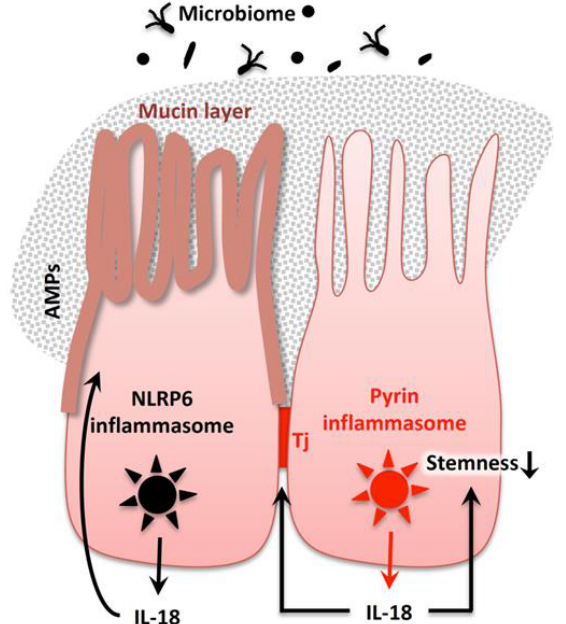
Figure 5. Importance of IL-18 for gut homeostasis. Intestinal epithelial cells utilize various inflammasomes for the constitutive production of IL-18. Under SPF conditions, colonic epithelial cells release IL-18 dependent on the NLRP6 inflammasome, which in turn activates epithelial cells to produce antimicrobial peptides (AMPs) to maintain microbiome homeostasis. Nlrp6 − / − mice spontaneously develop dysbiosis resulting in colitis. The NLRP6 inflammasome is involved in the generation of the homeostatic mucin layer by intestinal epithelial cells. IL-18 derived from pyrin inflammasome activation is involved in gut homeostasis through the generation of intact tight junction (Tj) formation. Furthermore, pyrin inflammation-mediated IL-18 protects against colitis-associated colorectal cancer by reducing the stemness of colon epithelial cells.